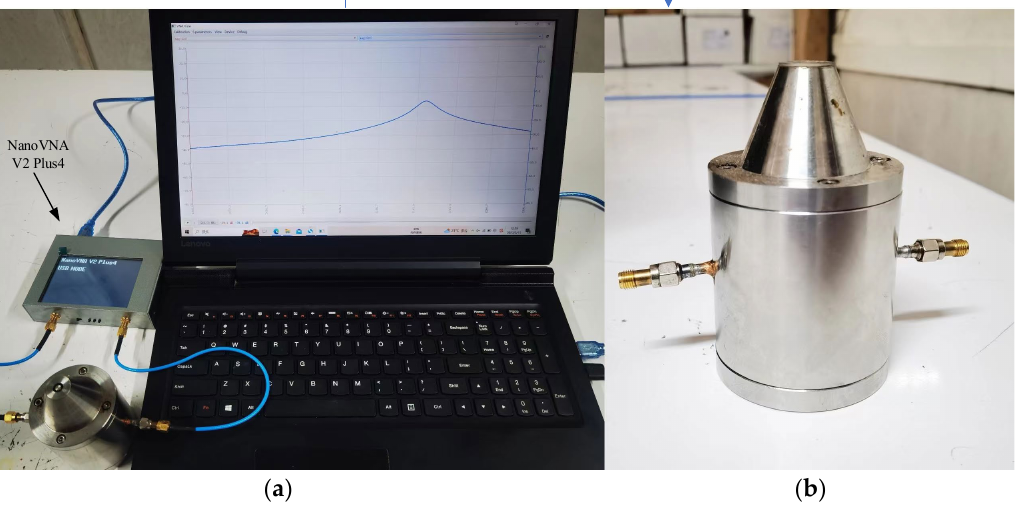
Figure 1. Establishment of experimental platform. ( a ) Experimental setup; ( b ) Resonant cavity.